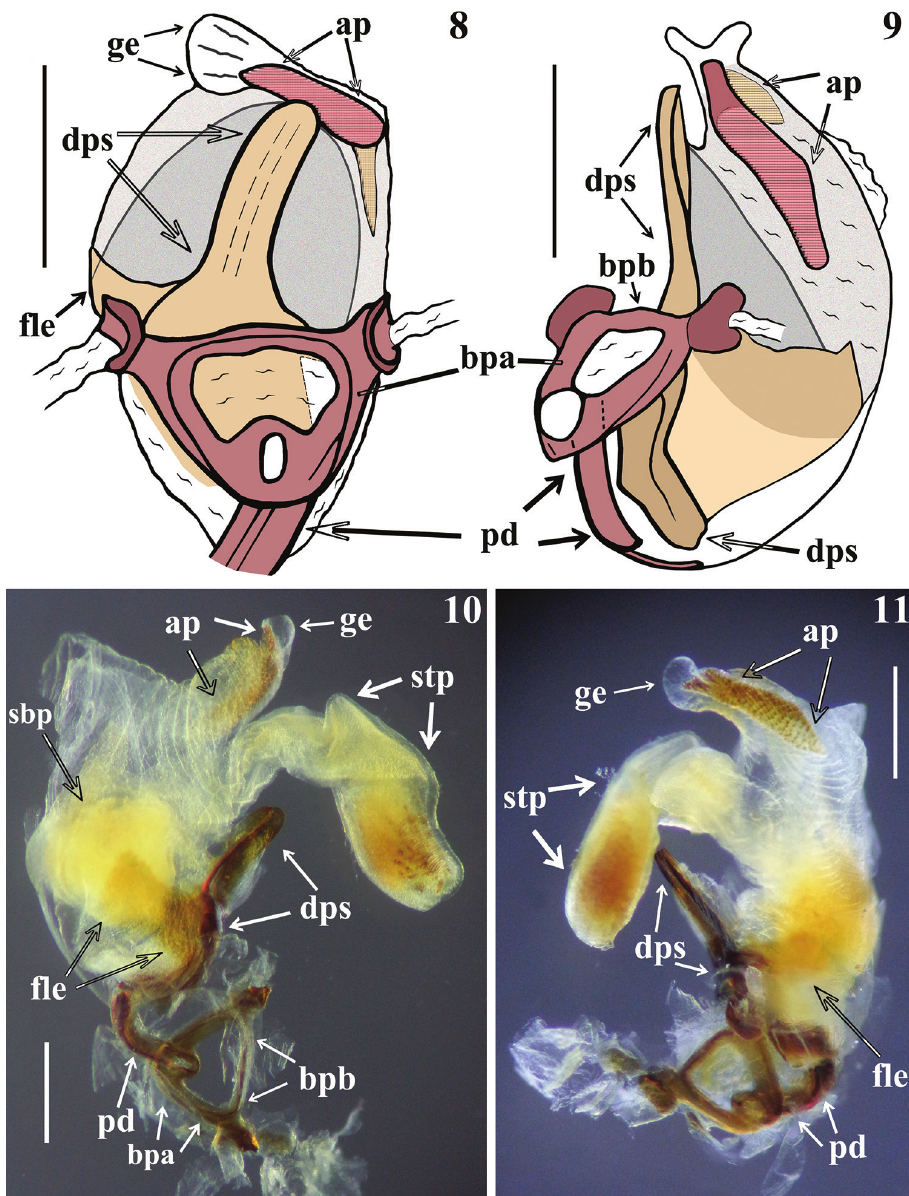
dorsal view 10–11 phallus with endosoma inflated, lateral views. ( ap apical process of endosoma; bpa ba- sal plate arm; bpb basal plate bridge; dps dorsal phallothecal sclerite; fle flat lateral expansion; ge globose expansion of endosoma; pd pedicel; sbp subbasal process of endosoma; stp subapical tubular projection of endosoma wall). Scale bars: 0.5